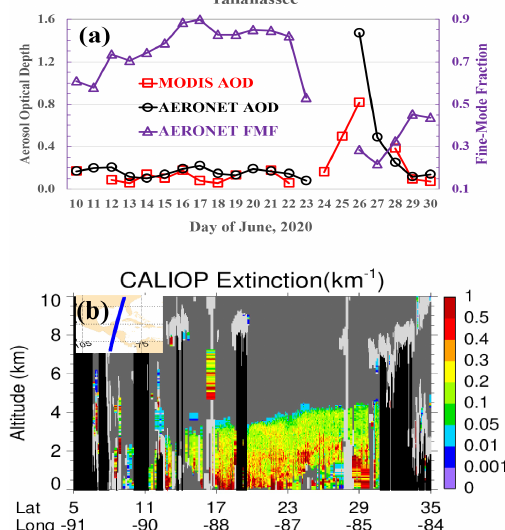
Figure 8. The intrusion of African dust into the Florida panhandle as evidenced in remote sensing observations: (a) evolution of AOD (black from AERONET and red from MODIS, left axis) and FMF (purple from AERONET, right axis) over Tallahassee, Florida, dur- ing 10–30 June 2020; (b) curtain of CALIOP–CALIPSO aerosol ex- tinction (at 532nm) along a CALIPSO track overpassing the Florida panhandle on 25 June 2020. The x axis denotes latitude and longi- tude of the CALIPSO